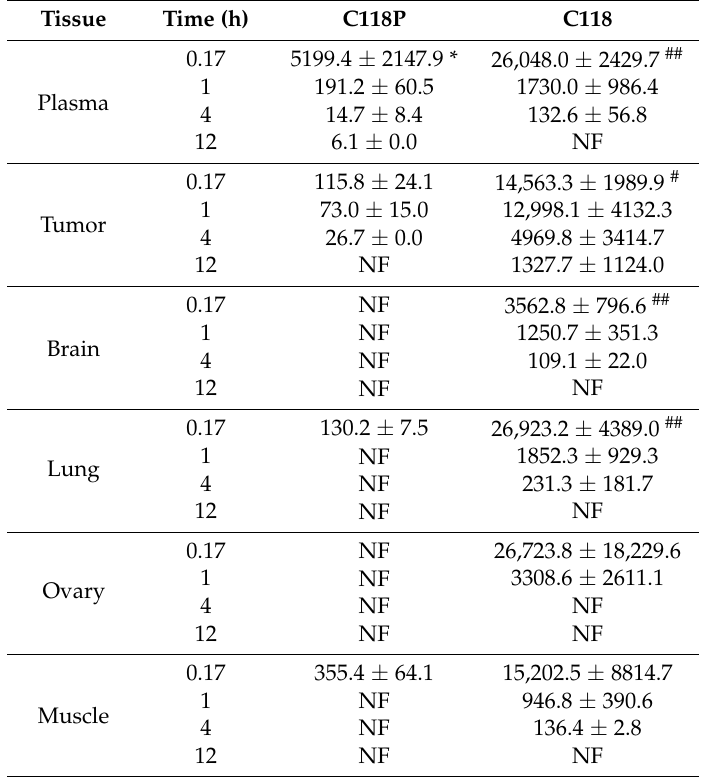
Table 4. The distribution of C118P and C118 in tumor bearing mice after i.v. injection of 75 mg/kg of C118P ( n = 4, mean ±